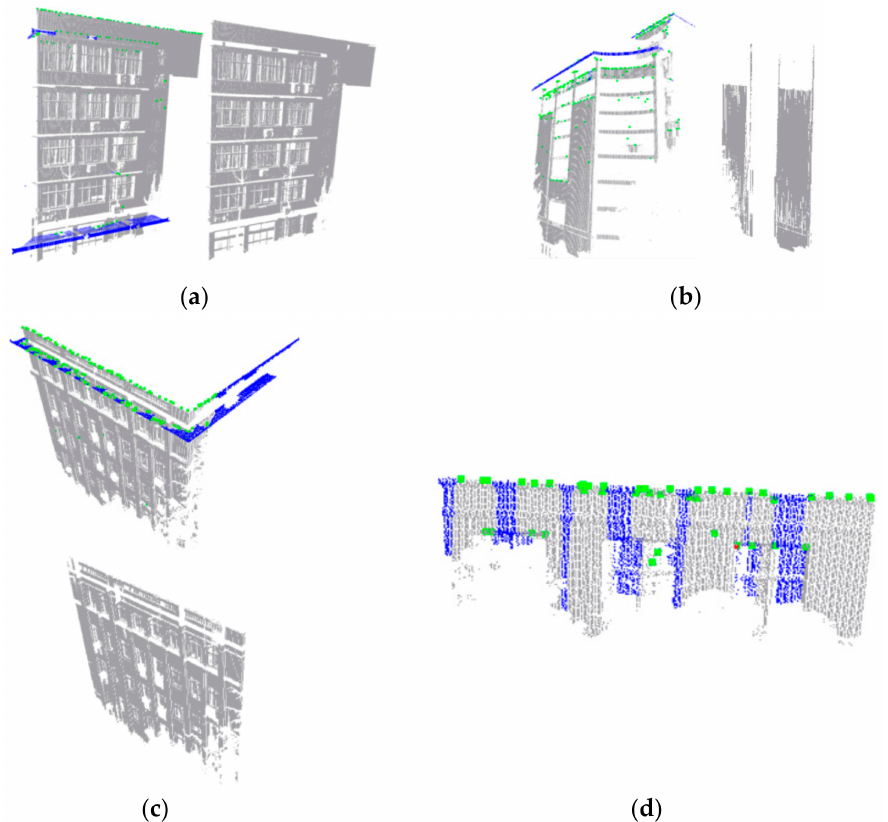
Figure 12. Comparison of result details. Left in ( a – c ): our results; right in ( a – c ): results of the original DoPP. The facade in ( d ) is removed by the original DoPP and only our result is shown. Gray points are facade points, green points are seed points for roof extraction and blue points are results of the roof extraction.